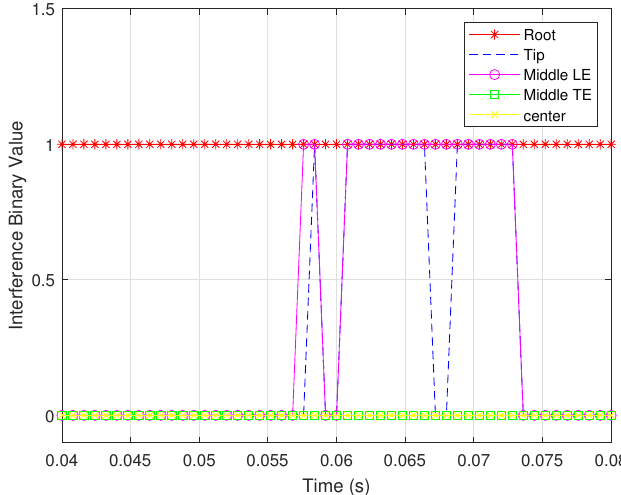
Figure 15. Interference binary values for shear strain sensors located in different places.